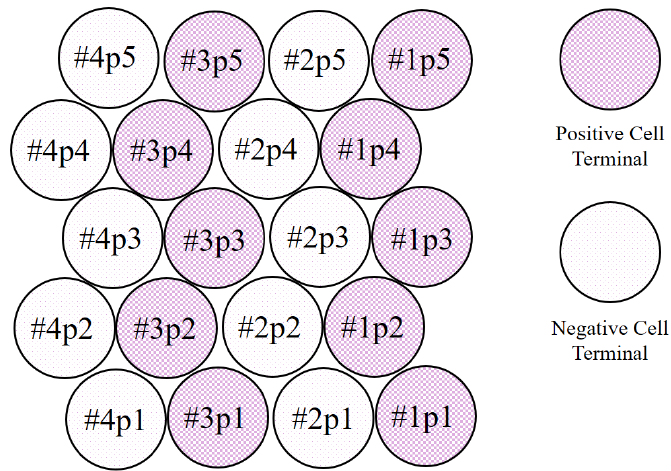
Figure 1. Top view on the mechanical cell configuration as a 4s5p (4 cells in series with 5 cells in parallel each) battery. The numbering of the cells contains information about their position. For example, Cell #1p3 is the third cell from Cell Level